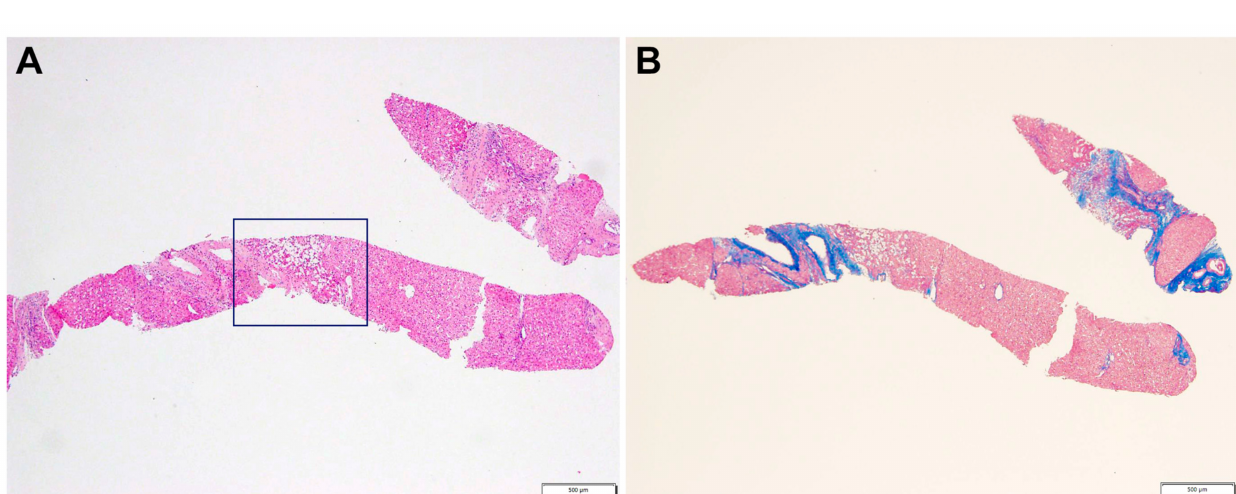
Figure 2. Liver biopsy: ( A ) expanded portal tract with mild inflammatory infiltrate. Inset displays a cluster of empty cells near an anatomical septum (HE, 4 × ). ( B ) Disturbed architecture due to fibrous porto-portal bridges consistent with cirrhosis (Masson 4 ×